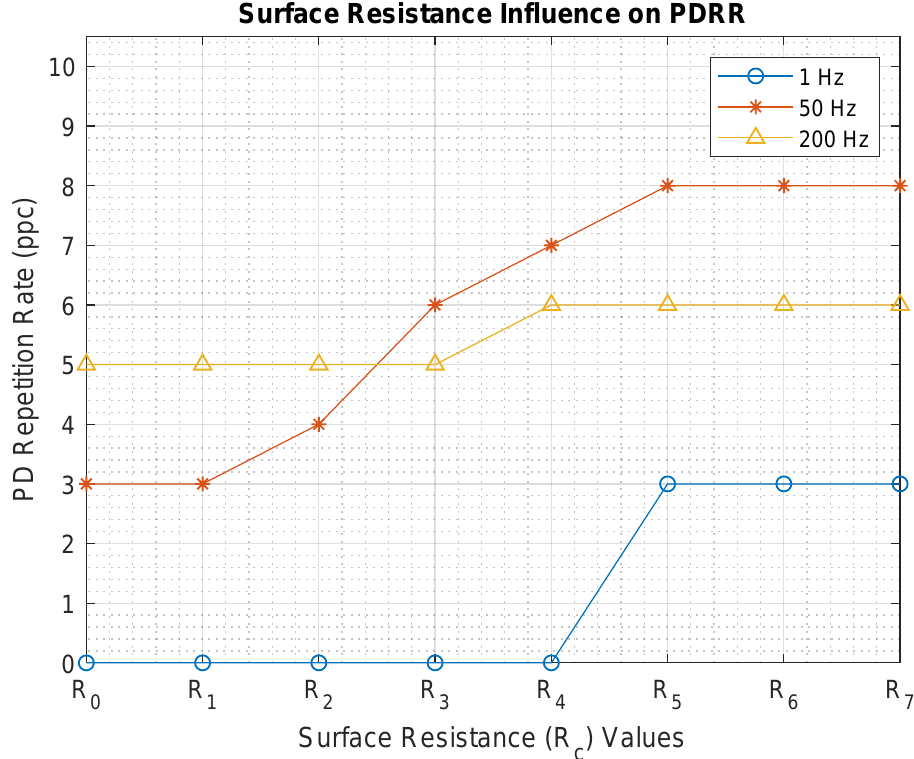
Figure 3. Cavity surface resistance influence on PDRR at different frequencies. Surface Resistance ( R c ) values: R 0 = 3.0 × 10 9 Ω , R 1 = 6.0 × 10 9 Ω , R 2 = 9.0 × 10 9 Ω , R 3 = 3.0 × 10 10 Ω , R 4 = 9.0 × 10 10 Ω , R 5 = 6.0 × 10 12 Ω , R 6 = 9.0 × 10 12 Ω , and R 7 = 3.0 × 10 15 Ω